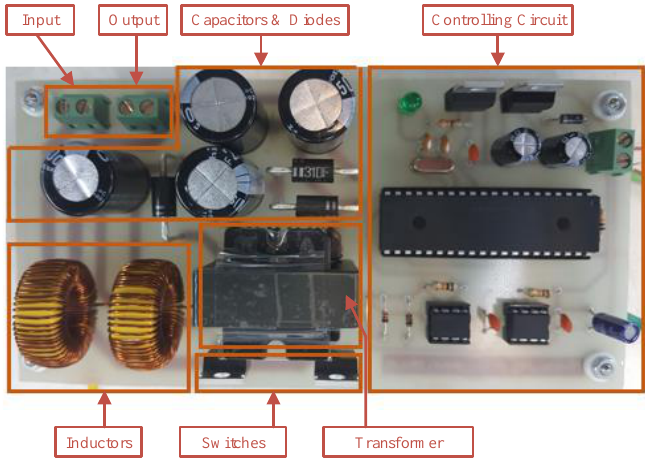
Figure 12. Laboratory prototype of the proposed